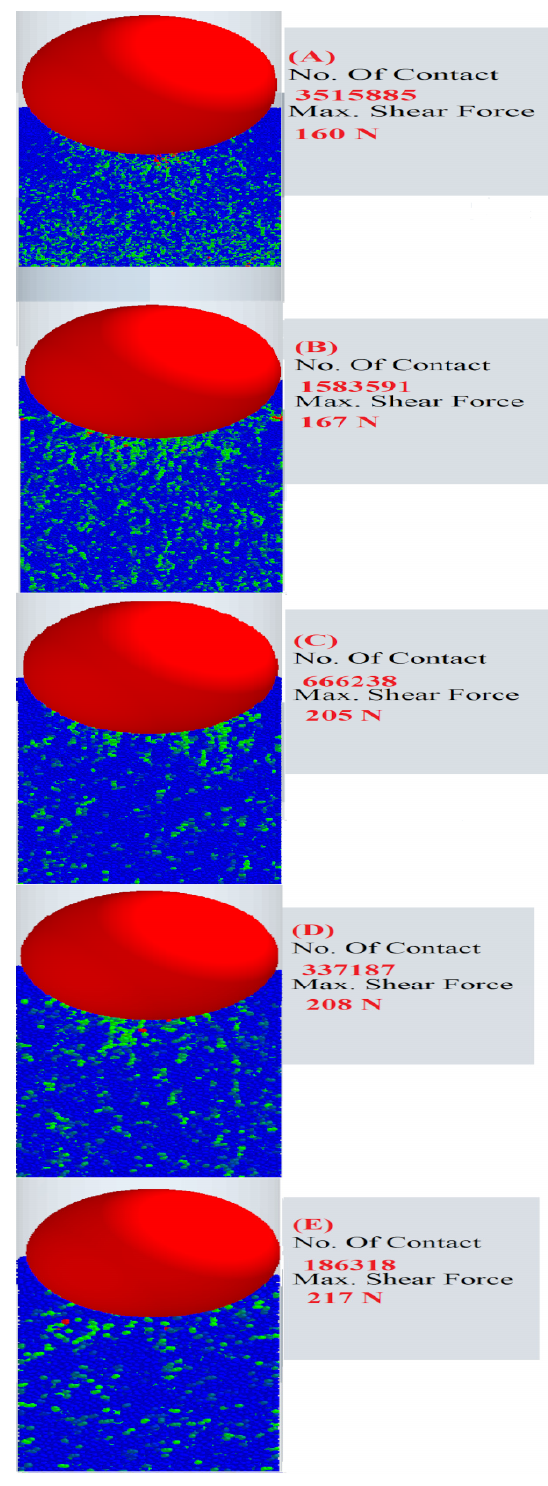
Figure 11 Distribution of contact force chains for various SI particles at shear strain of 0% and 30kPa normal stress (Size index SI= 50%, 75%, 100%, 125%, 150%